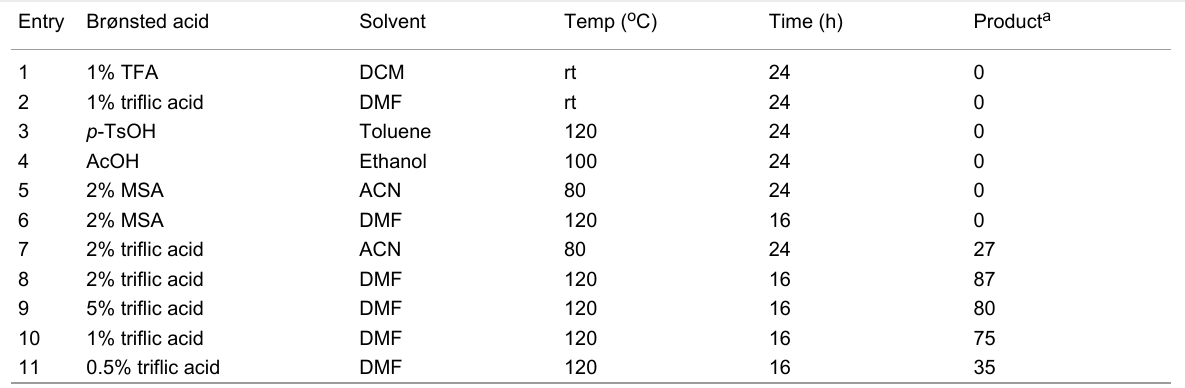
Table 1: Optimization of the reaction conditions for conversion of substrate 2a to 9a . Entry Brønsted